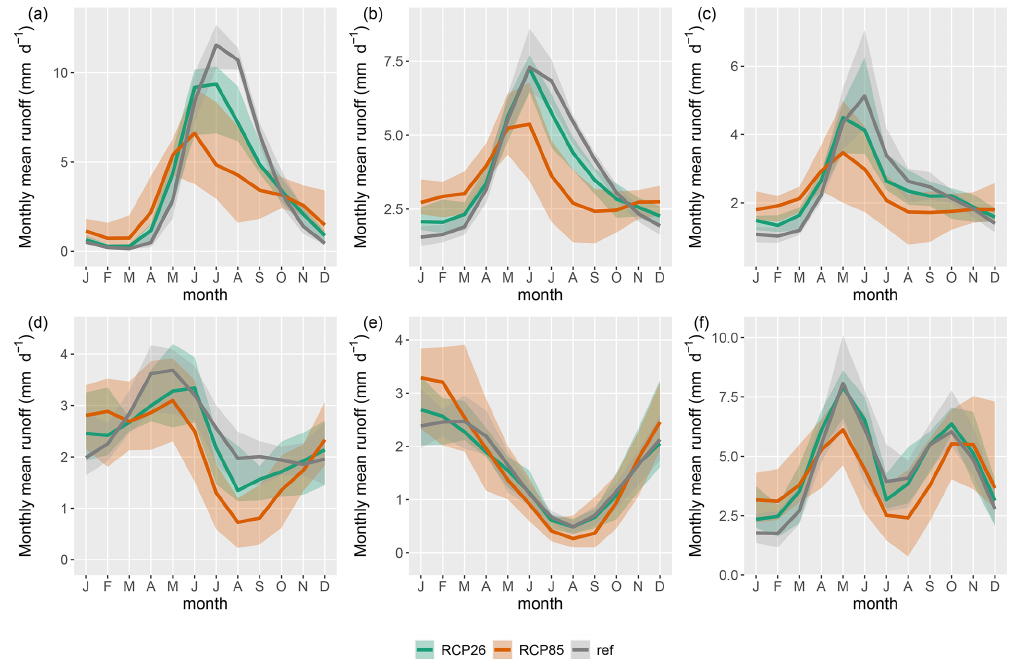
Figure 5. Runoff regimes for the six representative catchments: Rosegbach (a) , Kander (b) , Plessur (c) , Emme (d) , Venoge (e) , and Verza- sca (f) . Thick lines represent the multimodel median for the reference period (grey), for 2070–2099 under RCP2.6 (turquoise), and for 2070– 2099 under RCP8.5 (orange). Shading shows the full model range for each